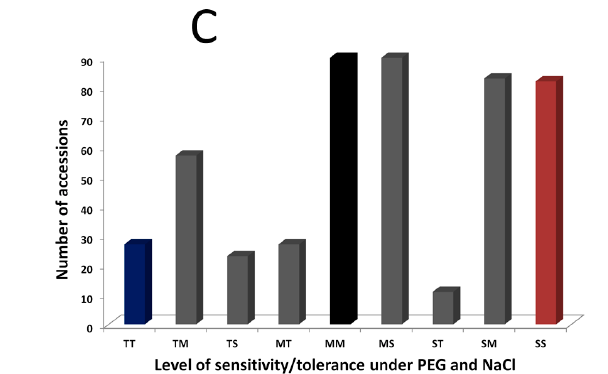
Figure 3. Classification of 490 sesame accessions according to their levels of tolerance/sensitivity to PEG and NaCl stresses. ( A ) Dendrogram and heat map hierarchical clustering of the accessions according to their tolerance levels to NaCl. ( B ) Dendrogram and heat map hierarchical clustering of the accessions according to their tolerance levels to PEG. The cluster colored in carmine gathers the sensitive accessions, the blue one is for the tolerant accessions and the black cluster represents the moderately tolerant accessions. ( C ) Comparison of the responses of the accessions to PEG and NaCl. The bars showed the proportion of accessions according to their responses to both stresses. The bars colored in blue, black and carmine represent the accessions which were commonly tolerant, moderately tolerant and sensitive to both stresses, respectively. The bars colored in gray represent the genotypes displaying contrasting responses to PEG and NaCl treatments. T = Tolerant, M = Moderately tolerant, S = Sensitive, based on the classification of the dendrogram. The first letter refers to PEG while the second letter refers to NaCl. Genes 2018 , 9 , x FOR PEER REVIEW